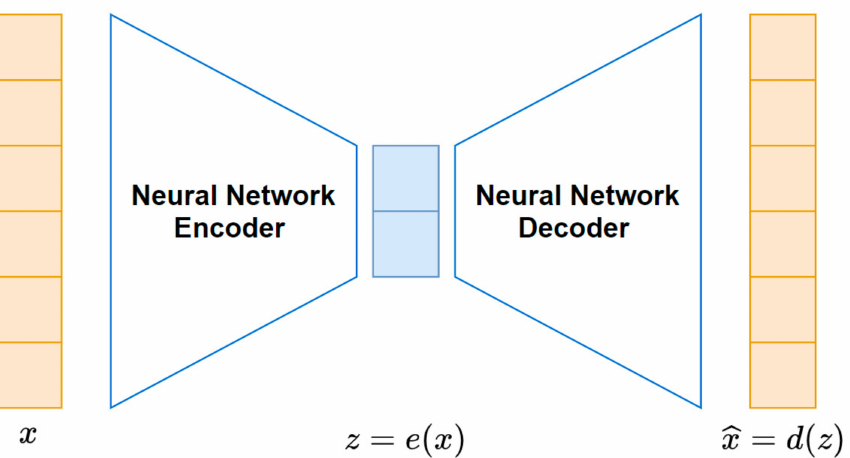
Figure 4. Autoencoder schematic. x is trained by the encoder to obtain the low-dimensional hidden space z . After reducing z to ˆ x , which is similar to x by the decoder, we continuously optimized ˆ x by the loss function to keep ˆ x close to x